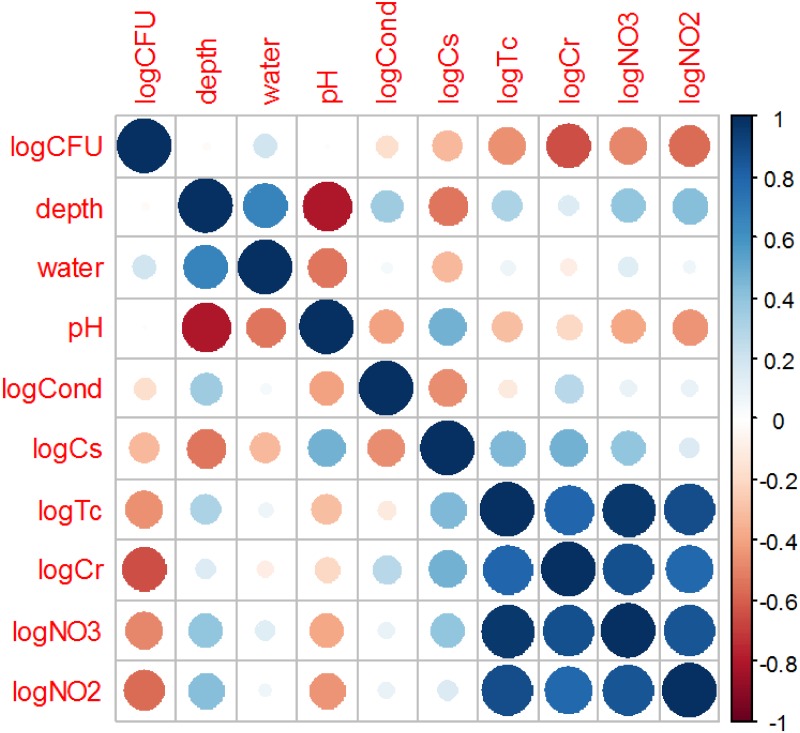
Graphical representation of Pearson correlations between numerical variables in data set II (bacteria at Hanford).